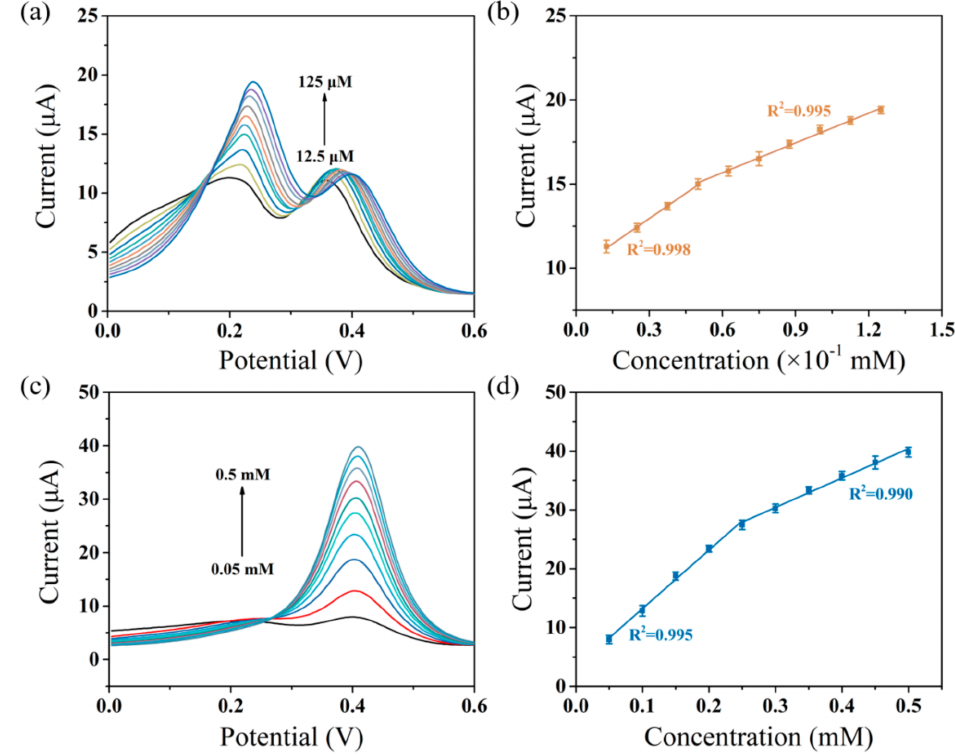
Figure 5. ( a ) Differential pulse voltammetry (DPV) responses of the MXene/PPy modified electrode with different DA concentrations in the presence of 1 mM AA and 100 µ M UA; ( b ) a linear calibration curve for the current response of DA; ( c ) DPV responses of the MXene/PPy modified electrode with different UA concentrations in the presence of 1 mM AA and 50 µ M DA; ( d ) a linear calibration curve for the current response of